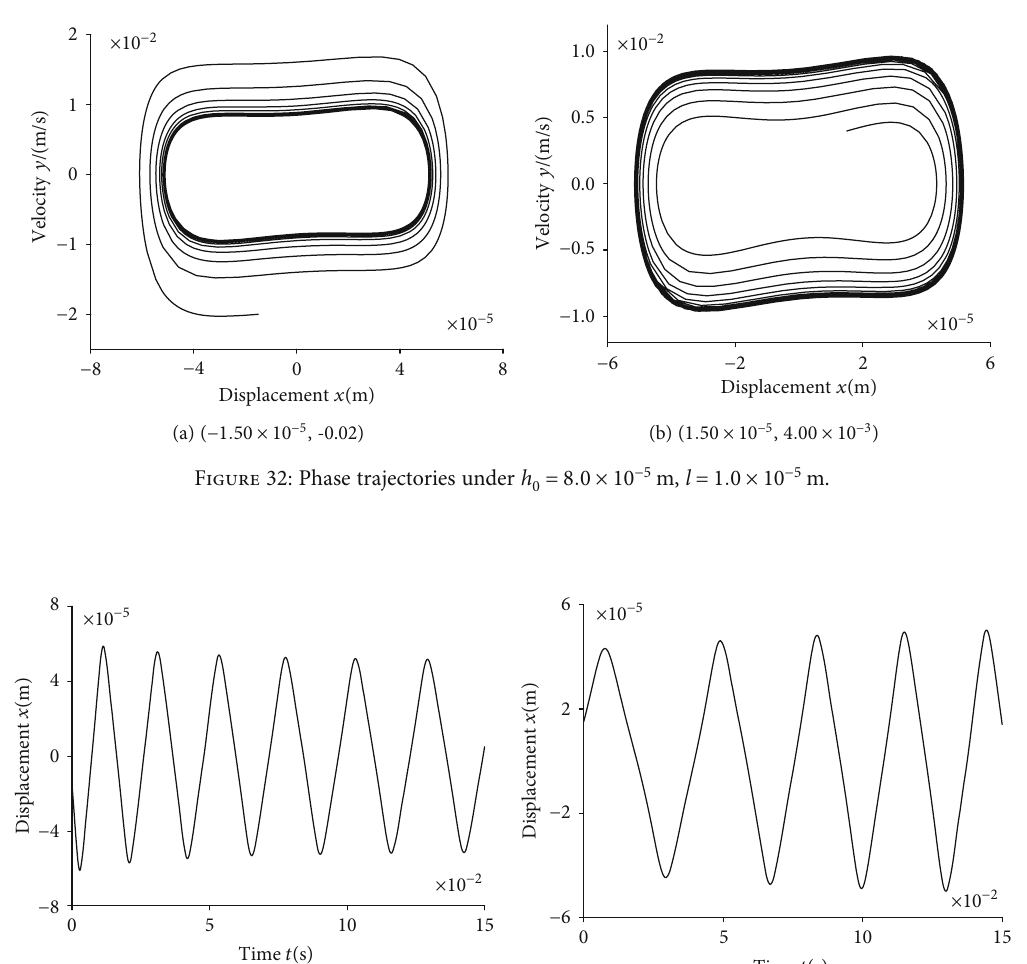
= 8 : 0 × 10 − 5 m , l = 2 : 0 × 10 − 5 m . 0